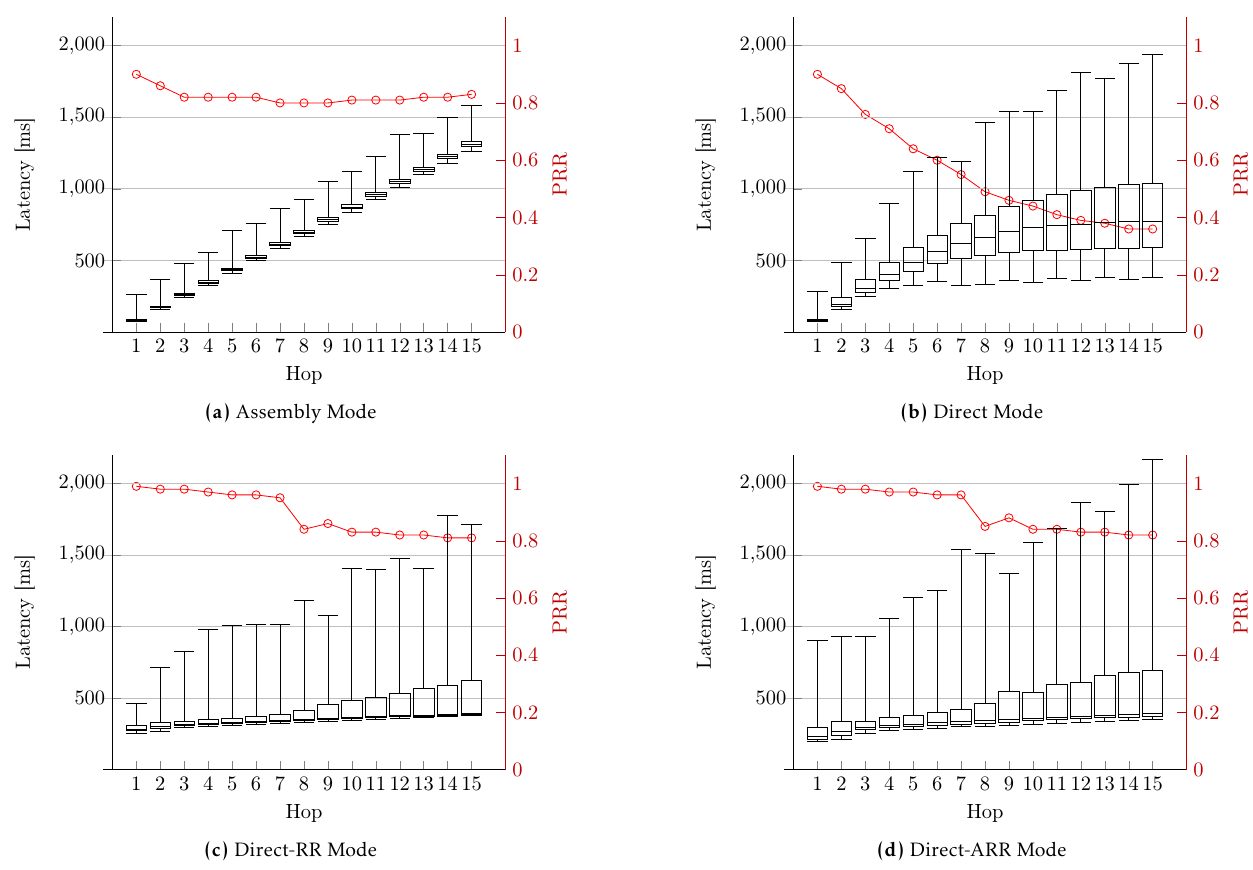
Figure 7. Per hop latency and PRR in the Long-Y Network with 37 . 5 B/s and 1200 bytes payload; first set of